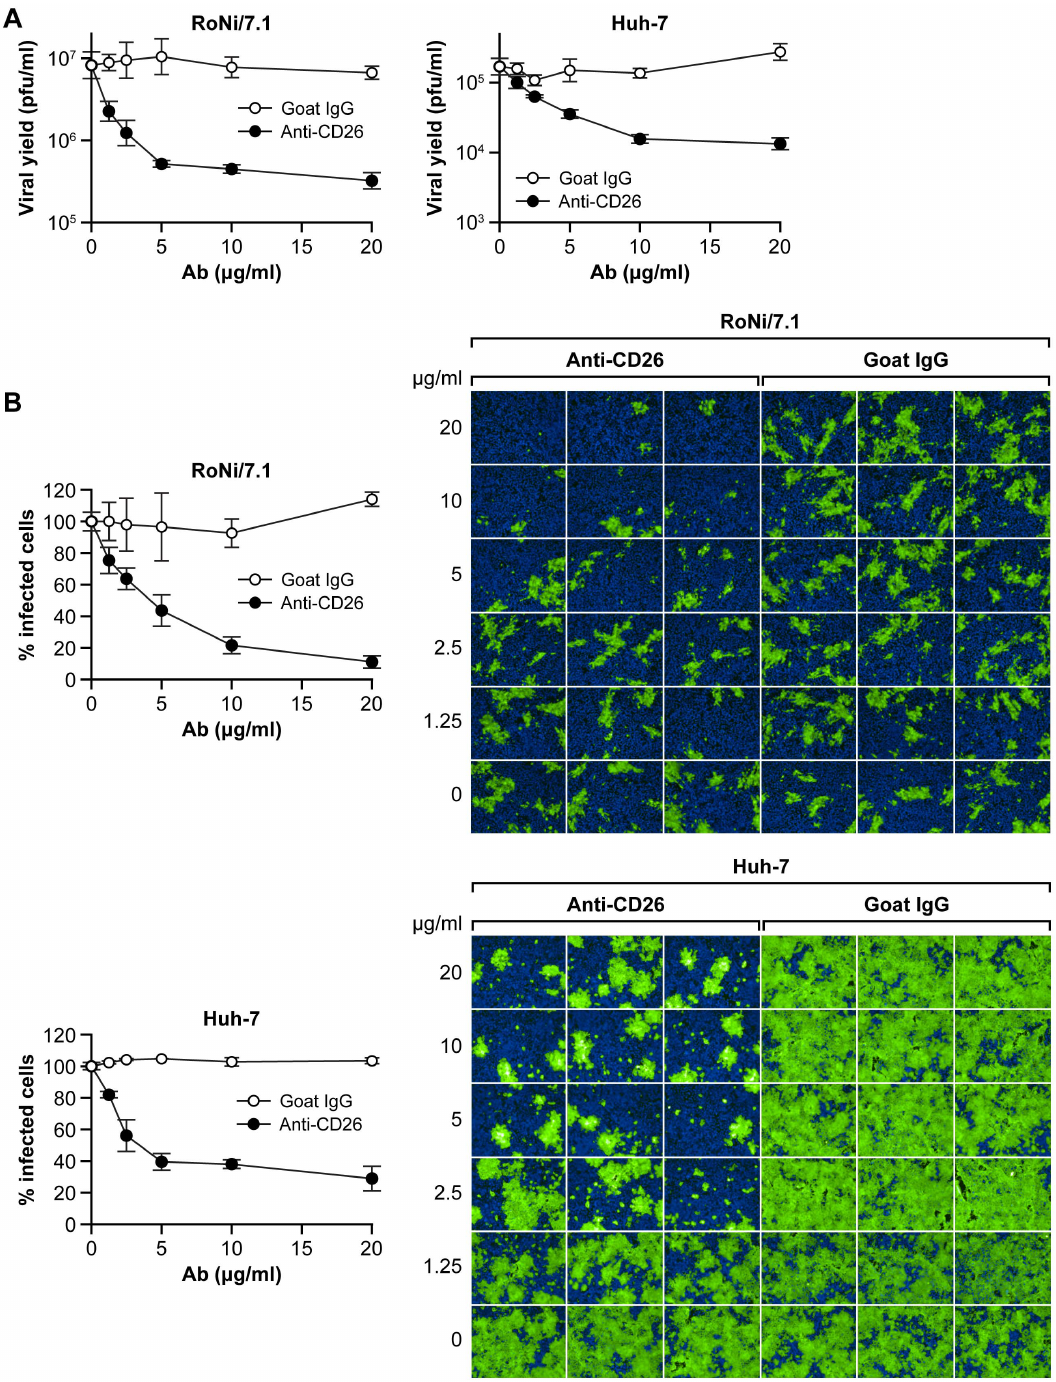
Figure 3. Anti-human CD26/DPP4 antibody inhibits MERS-CoV infection of bat cells. RoNi/7.1 or Huh-7 cells (control) were treated with increasing concentrations (0, 1.25, 2.5, 5, 10, and 20 m g/ml) of anti-human CD26/DPP4 antibody or control antibody and then exposed to MERS-CoV/ EMC at an MOI of 1. (A) After 24 h, viral yields in supernatants were determined by plaque assay. (B) Cellular infection was determined by immunofluorescence assay (IFA) with an anti-MERS-CoV spike protein antibody (green). (B left) The percentage of infected cells was analyzed by high content imaging. (B right) Representative IFA images. Error bars indicate the standard deviation of triplicate samples.